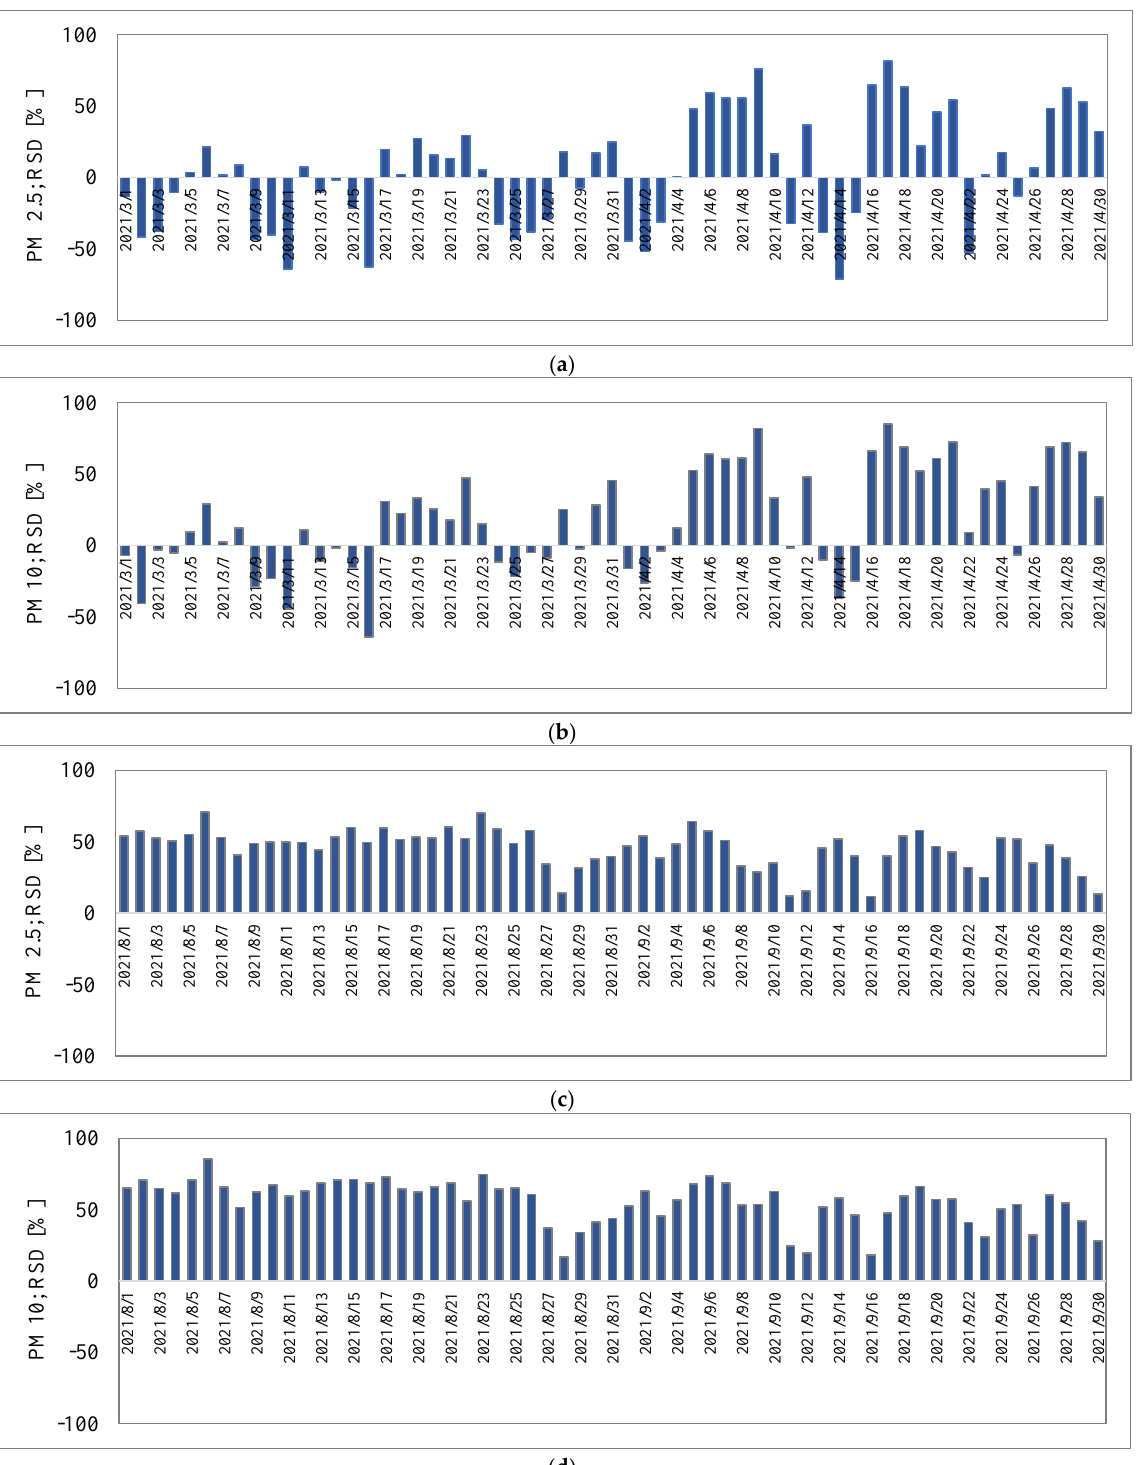
Figure 9. Relative standard deviation RSD (%) calculated for ( a ) PM2.5 and ( b ) PM10 concentration in March–April and for ( c ) PM2.5 and ( d ) PM10 concentration in August–September calculated assuming that the real value are the results obtained from the reference device EDM 180, and the measured values are the results from SEZO